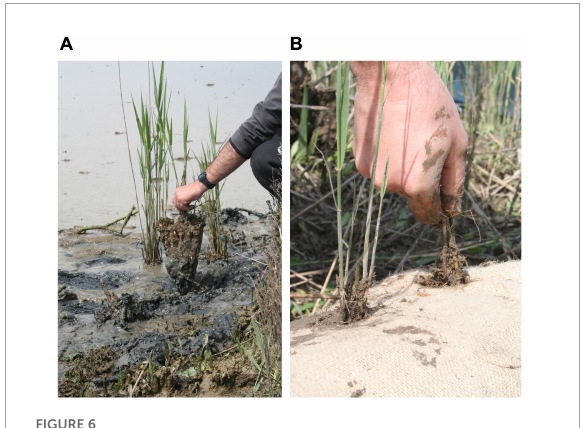
FIGURE6 Reedbed ( P. australis ) transplantations in mudflat (A) and in biodegradable module (B) .